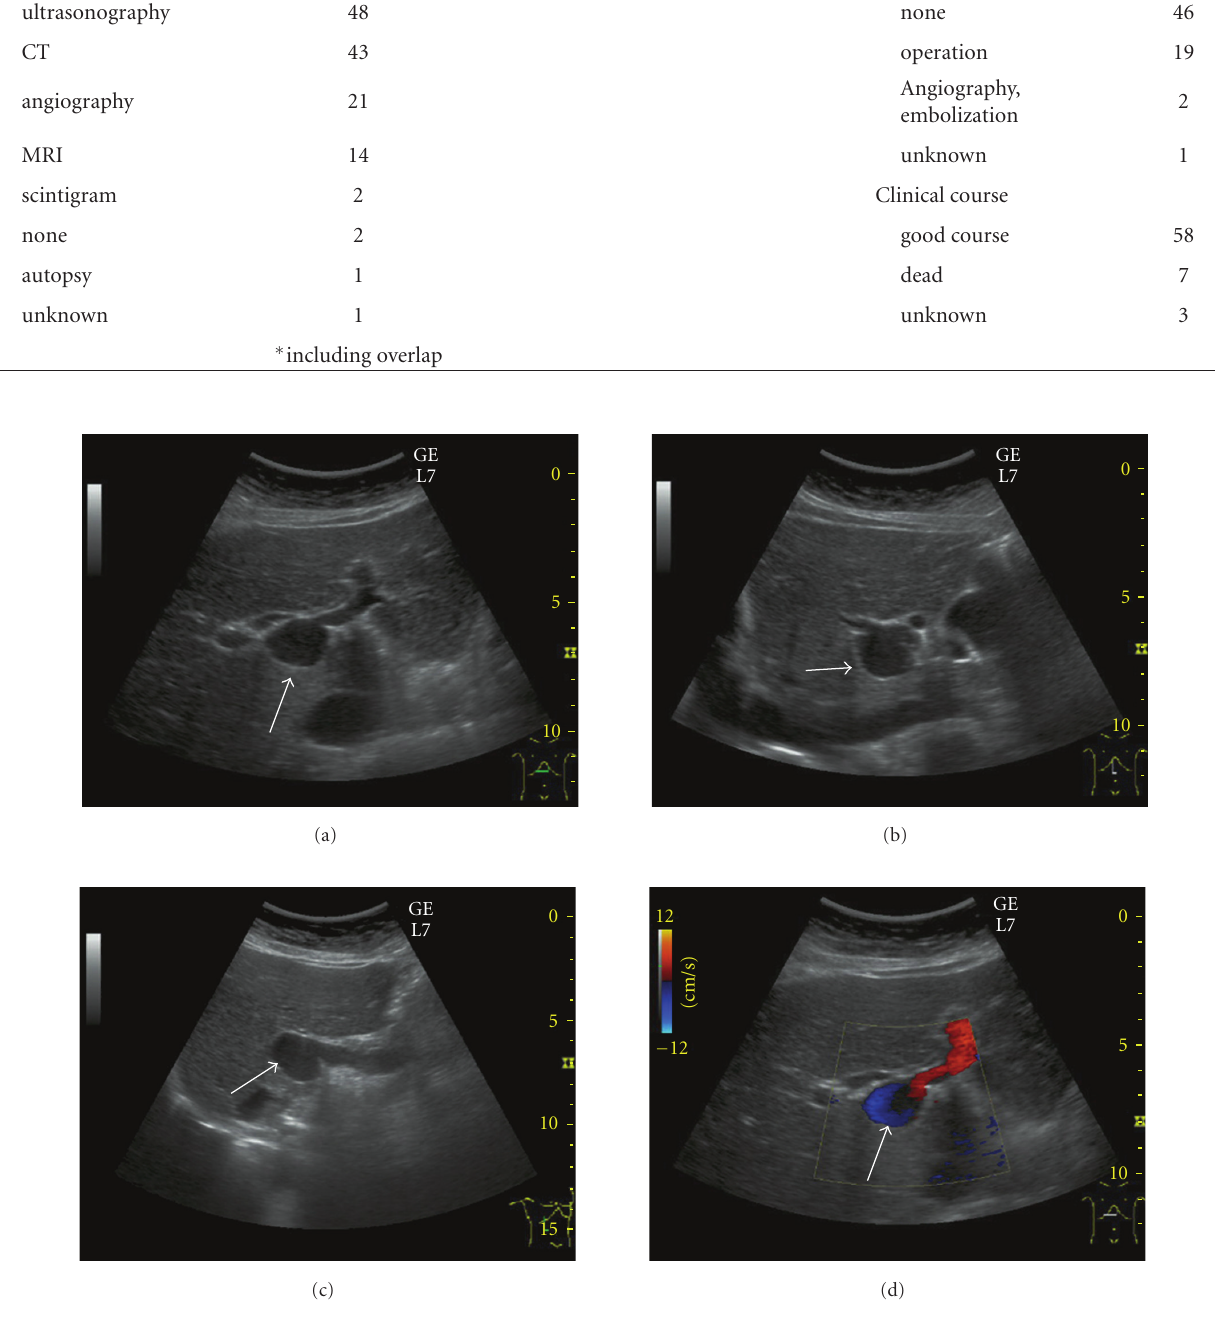
Figure 1: (a), (b), and (c) Ultrasonography (US) revealed a well-circumscribed anechoic structure that was 26.4 × 21.7 × 19.4 mm in size at the porta hepatis (white arrow). (d) Color Doppler US demonstrated bidirectional color due to circular flow within the